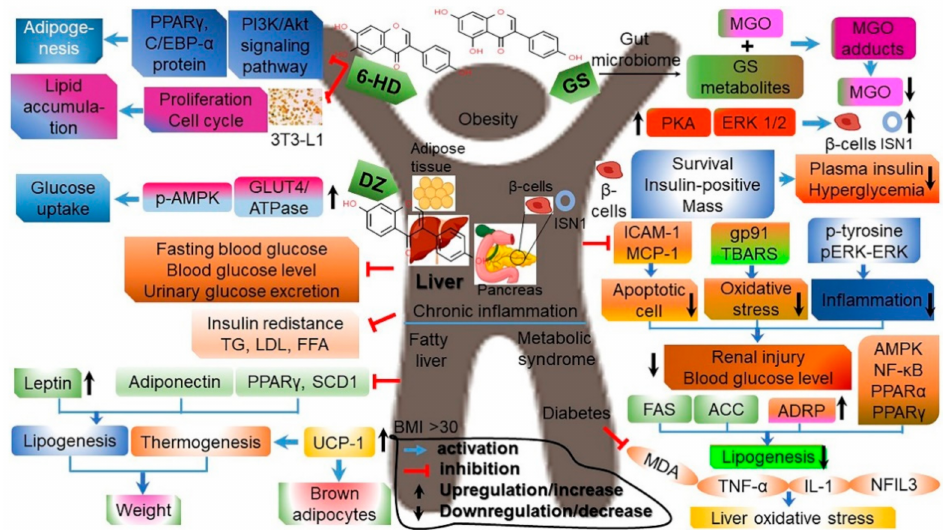
Wnt/ β -catenin pathway, whereas they inhibit receptor of activator of nuclear factor kappa B ligand